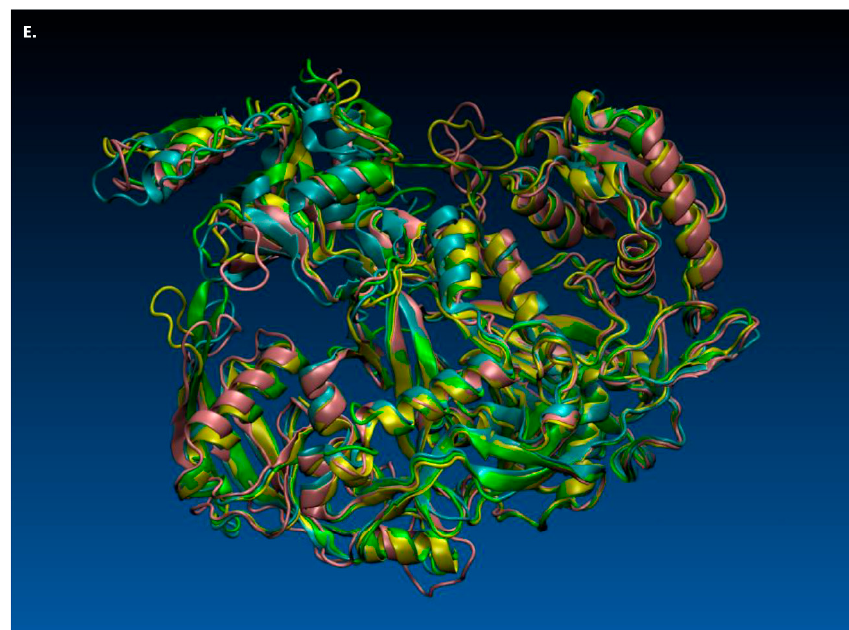
Figure 1. Comparative analysis of the human Argonaute (AGO) (AGO1–AGO4) protein-subfamily members. ( A ) Protein sequence similarity via global alignment. ( B ) Protein secondary structure via global alignment. ( C ) Coding-Sequence (CDS) similarity via global alignment. The alignments in ( A ) and ( C ) were yielded by the EMBL EMBOSS Needle with default settings [26]. The alignments in ( B ) were calculated using BioPython package with − 2 as open gap penalty score, − 1 as a gap extension penalty score, − 1 as a mismatch score, and 1 as a matching score. Protein sequences were retrieved from ENSEMBL [27]. Protein-secondary structures (DSSP entries) were retrieved from RCSB PDB [28]. Plots were generated with Matplotlib and Seaborn Python packages. ( D ) Domains of AGO1–4 with annotations for mutations [ (cid:4) = mutation]: G199S, P700A, and post-transcriptional modifications [ • = hydroxylation (h), (cid:73) = phosphorylation (p)]: hP700, pS387, pT529, pT749, and pT393, respectively. Domain information was retrieved from Pfam database [29]. Plots were generated with Matplotlib and Seaborn Python packages. ( E ) A superposition of the AGO 1–4 tertiary structures in New Cartoon representation, as displayed by VMD software [30]. These structural models are refined PDB data from 5VM9 [AGO3, pink colored] [16], and 6OON [AGO4, green colored] [33]. The structural data were further processed using Schrödinger Maestro Suite (Schrödinger Release 2020-2, [34]) by removing existing water molecules and ligands and filling missing loops and side chains [Prime] [35], calculating the protonation states on physiological pH 7.4 [PROPKA] [36,37], and minimizing the free energy of the resulting structures with the OPLS3 force field